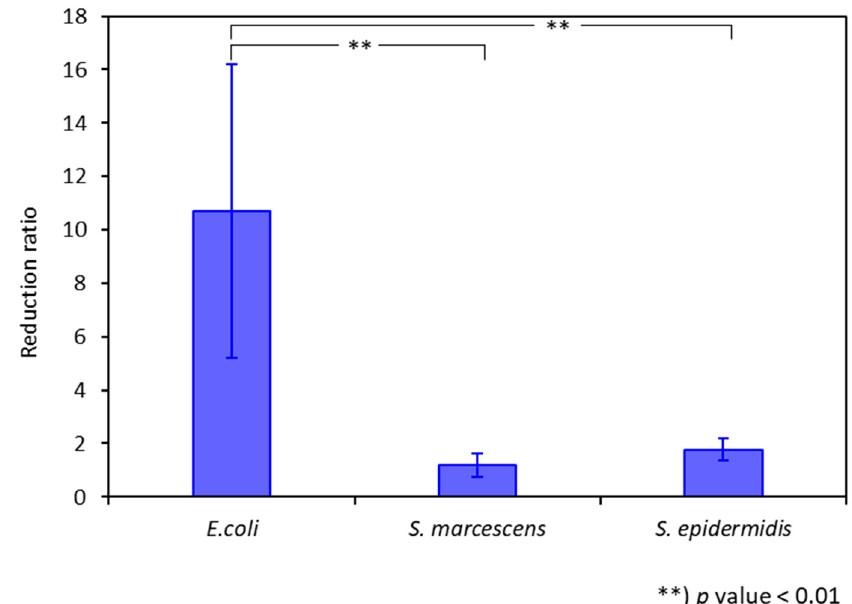
Figure 6. Antibacterial photothermal treatment (APTT) of AuNR-Ab-HNTs hybrids (1.5 mg mL − 1 , expected to contain 20 µ g mL − 1 AuNRs) against three different bacteria strains: E. coli (target bacteria), Serratia marcescens ( S. marcescens ), and Staphylococcus epidermidis ( S. epidermidis ). Irradiation conditions: 808 nm, 3.5 W cm − 2 after 12 min. **: p -value < 0.01 according to a two-tailed t -test.